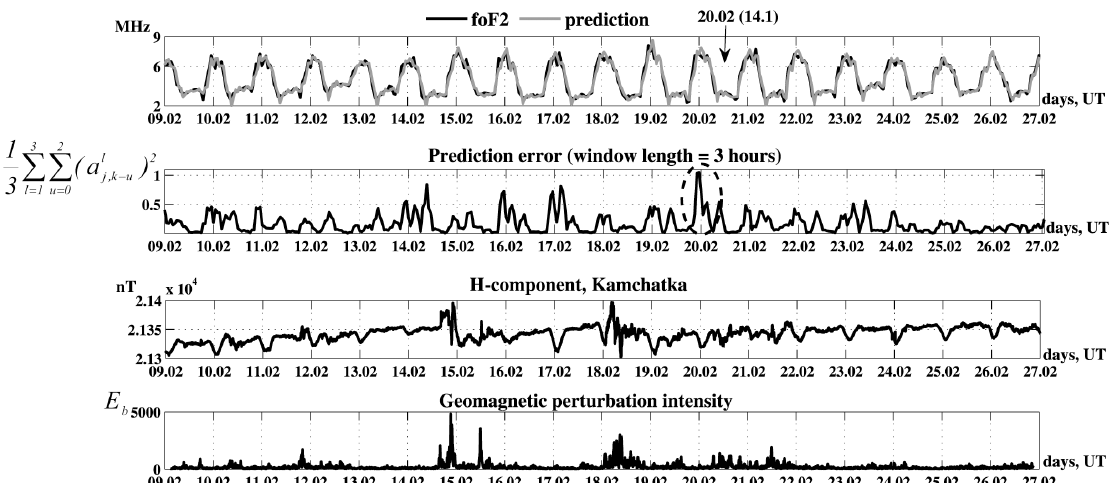
Figure 5. Detailed analysis of foF2 data for the period 09.02.2011–27.02.2011: prediction was performed using model (5) with time advance q =1; the arrow indicates a seismic event.